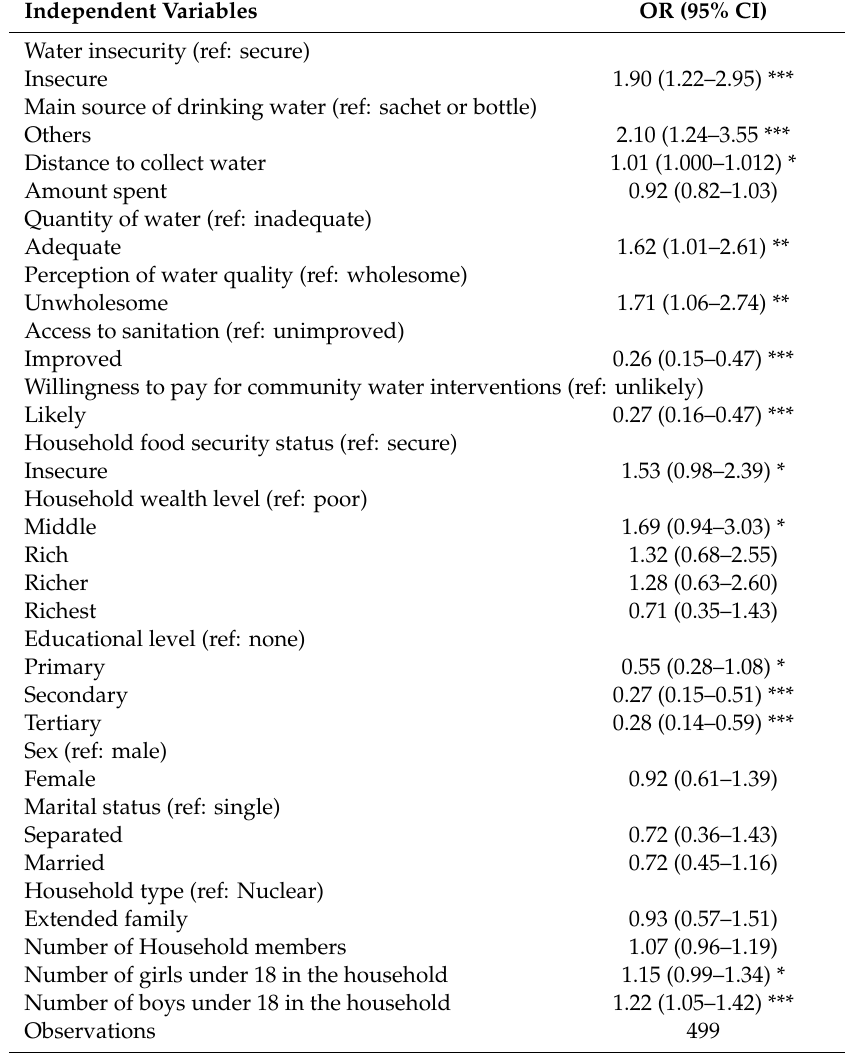
Table 2. Bivariate associations between emotional distress and selected independent